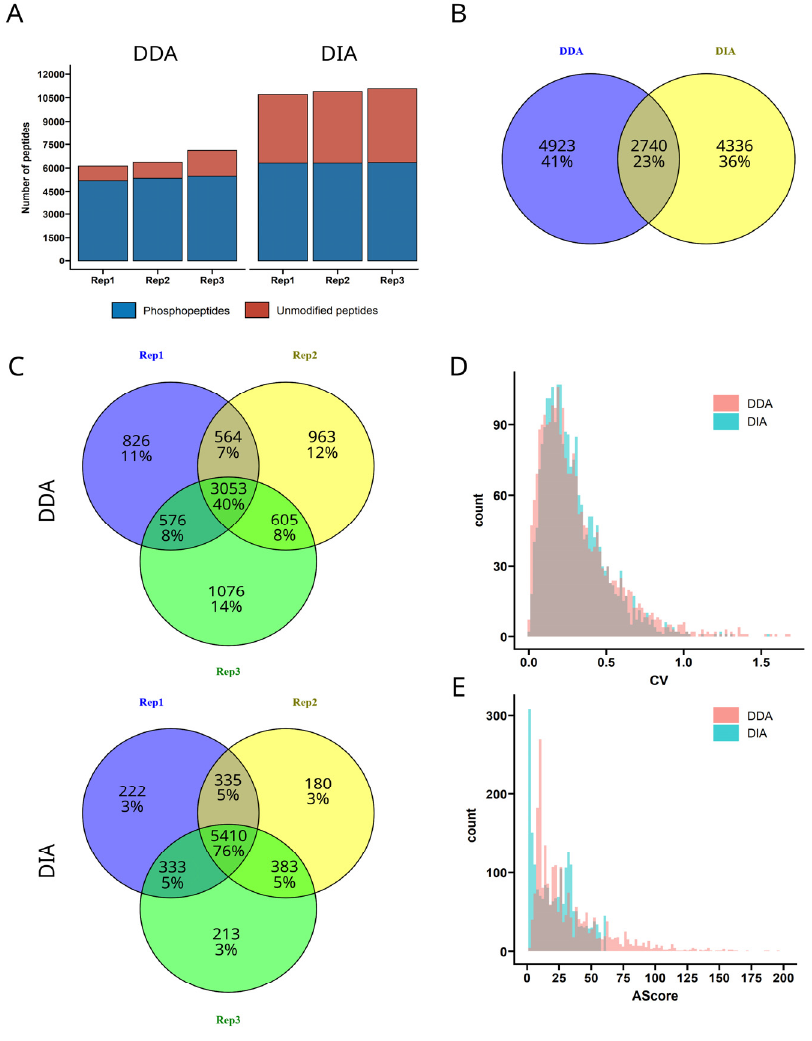
Figure 1. Performance comparison of three M. oryzae biological replicates measured in DDA and DIA regarding ( A ) peptide counts ( B ) overlap of identified phosphor-peptides ( C ) overlap within DDA and DIA replicates ( D ) precursor quantity reproducibility and ( E ) phosphosite identification confidence.